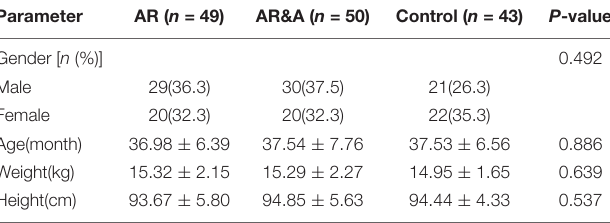
TABLE 1 | Demographic and anthropometric characteristics of the participants.